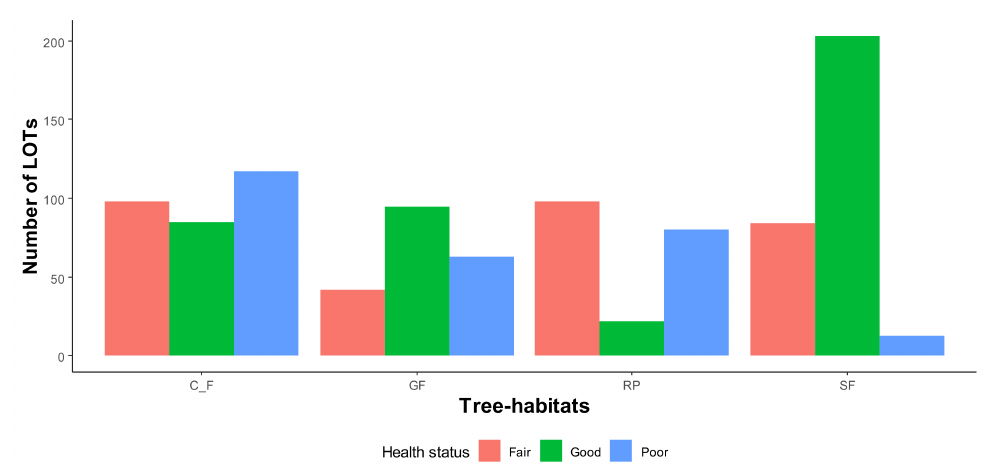
Figure 3. Health status of LOTs by cultural landscape. Legend: Poor health status: pronounced debarking, an undeveloped crown, enlarged branches; Fair health status: Slight debarking, medium crown development; Good health status: good development of the stem, good crown, and no debarking). C_F: Collective family space; RP: Royal palace; GF: Gazetted Forest; SF: Sacred forest.